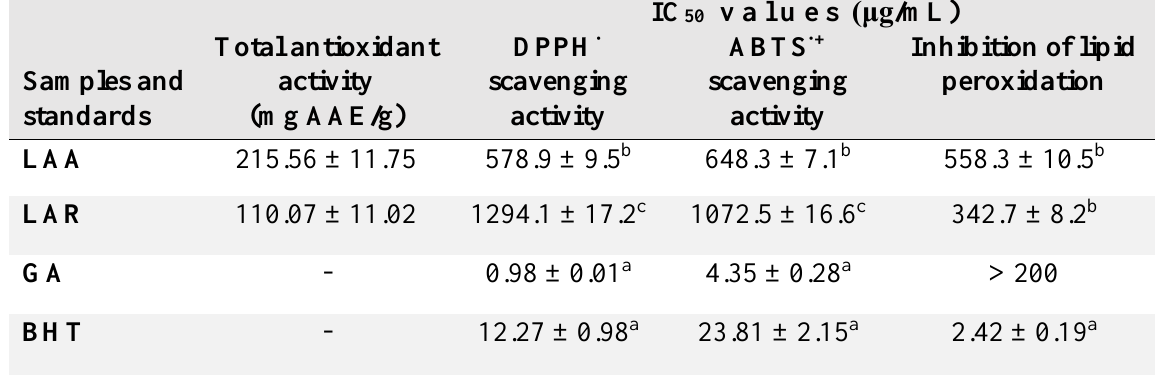
Table 2. Antioxidant activity of Lunaria annua aboveground part and root extracts (LAA and LAR).